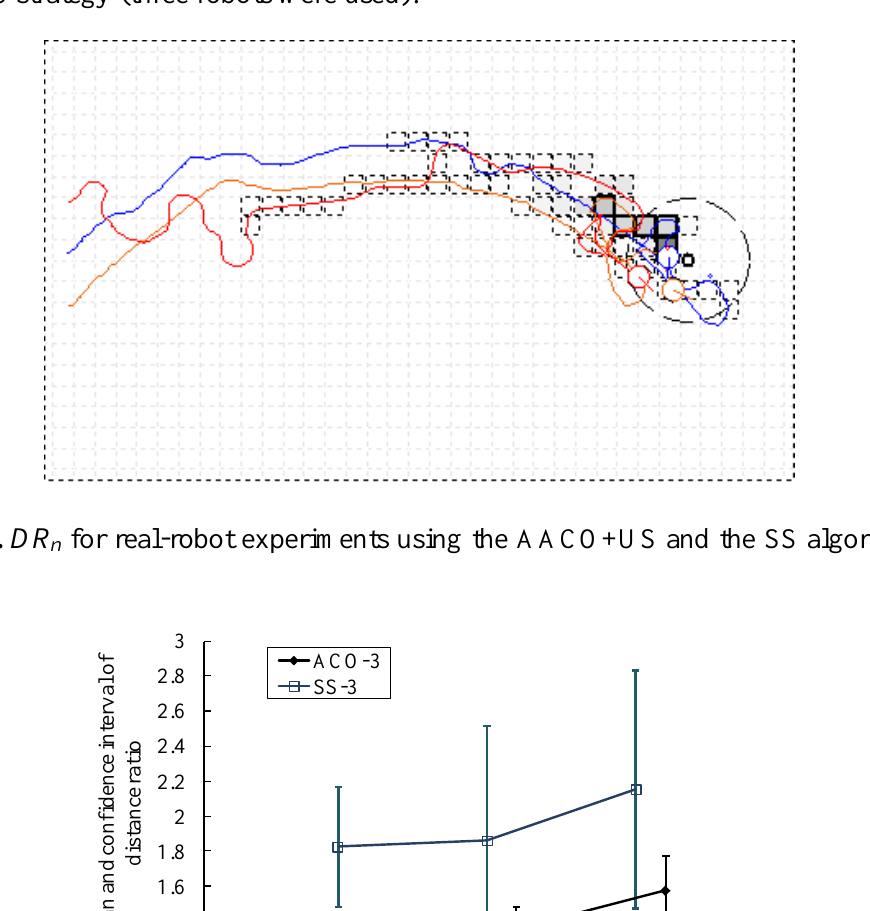
Figure 18. One of recorded CPT processes in the natural airflow field of Arena II using the AACO+US strategy (three robots were used).